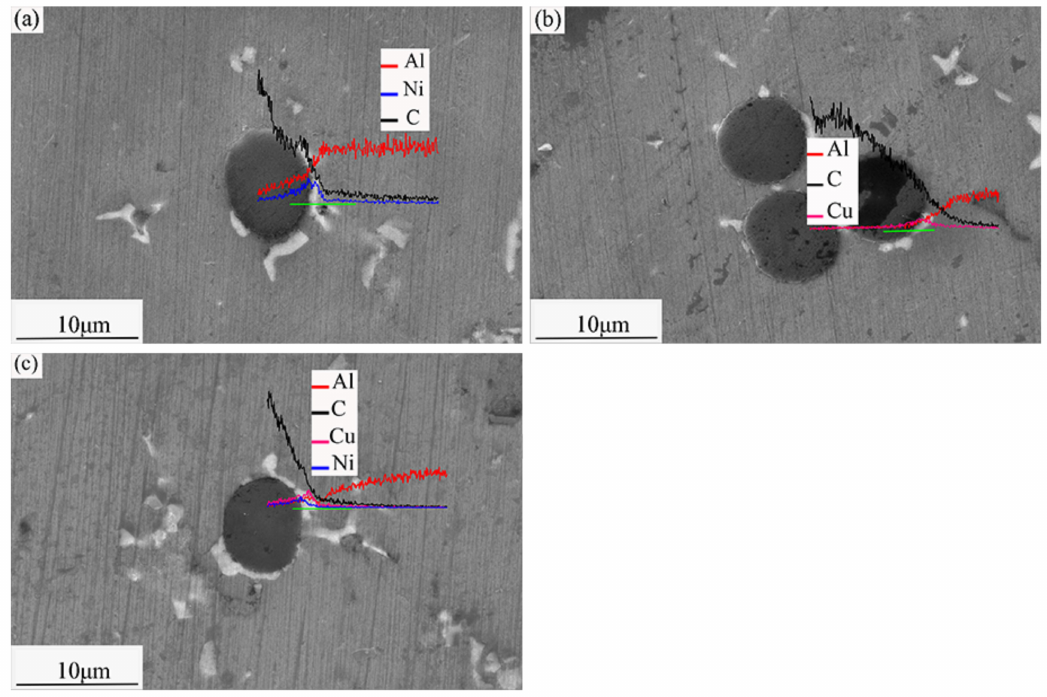
Figure 5. SEM images of microstructures of the composites: ( a ) Ni-Cf / Al; ( b ) Cu-Cf / Al; and ( c ) Cu-Ni-Cf / Al.